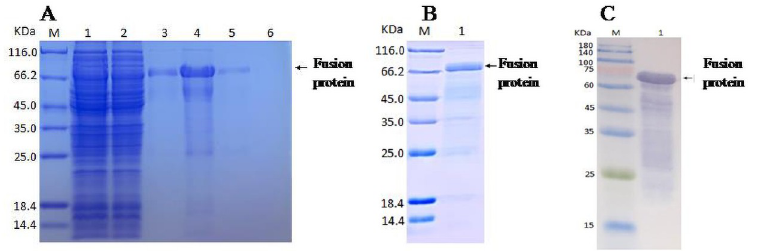
Fig 2. SDS-PAGE and Western blot analysis of fusion protein. (A)SDS-PAGE result of fusion protein in the process of purification (M, marker; lane1, loading solution; lane2, flow-through solution; lane3-4, 20 mM imidazole elution fraction; lane5, 50 mM imidazole elution fraction; lane6, 500 mM imidazole elution fraction). (B) SDS-PAGE result of purified fusion protein (M, marker; lane1, purified protein). (C) Western blot result of purified fusion protein (M, marker; lane1, purified